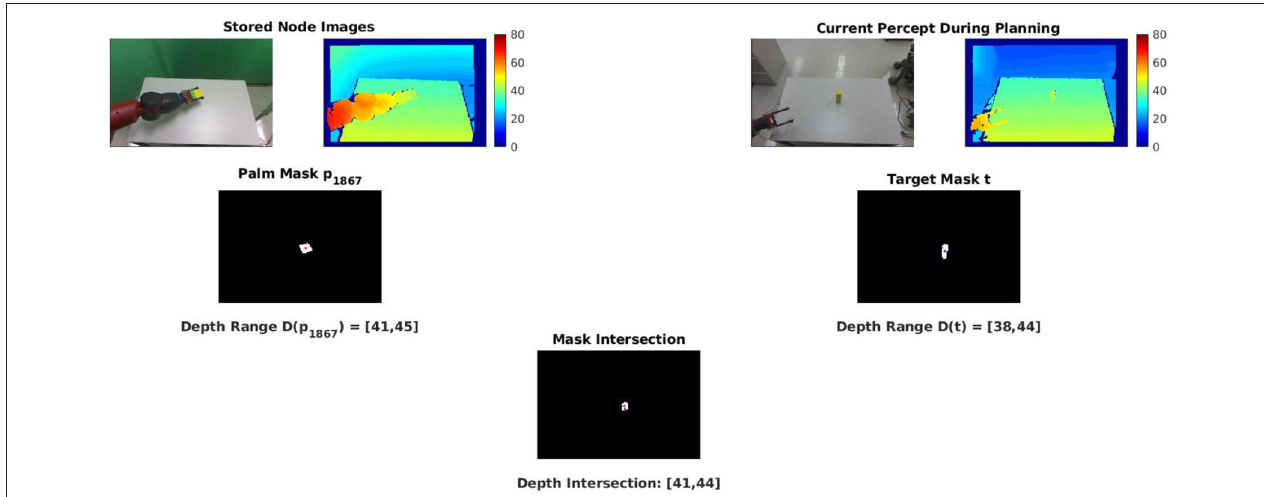
FIGURE 4 | Candidate final nodes are identified from their intersection features. (Top row) RGB-D percepts taken from the node definition (left two) and from the current percept of the environment (right two). (Middle row) The palm masks and depth ranges from the stored percept (left) and current percept (right). (Bottom row) The intersections of the palm masks and the depth ranges are both non-empty, so the current node is identified as a candidate for reaching the observed block. The palm masks and depth ranges for each node can be computed in advance. The intersections of the mask and range from a target block can be quickly evaluated for all 3,000 PPS graph nodes to generate the set of candidate final nodes.